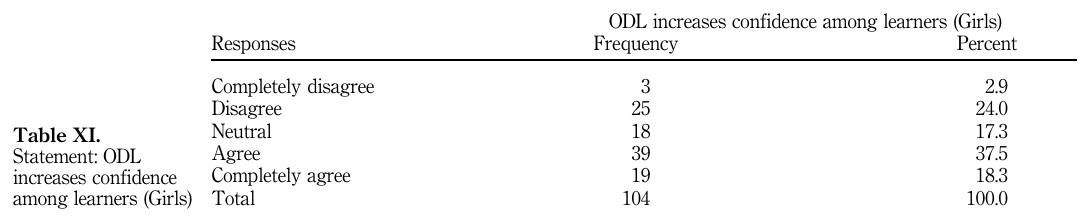
Table X. Statement: ODL increases confidence among learners